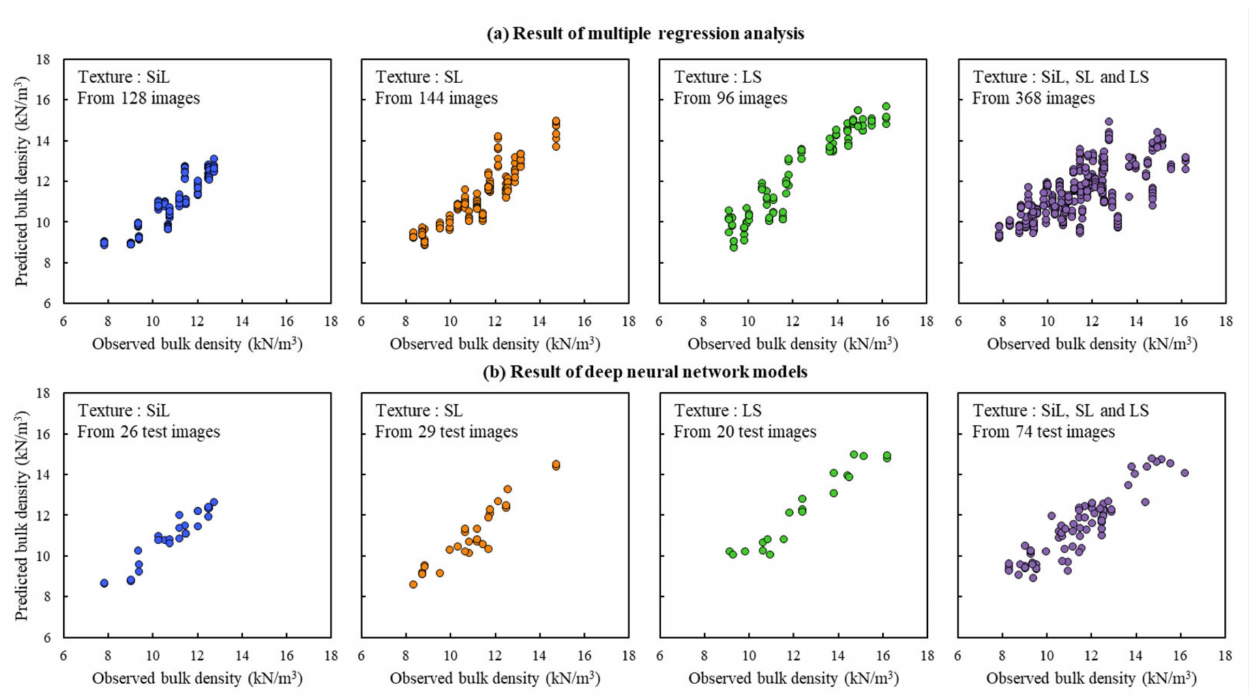
Figure 7. Prediction result of bulk density using features from soil surface images produced by multiple regression analysis and the deep neural network regression